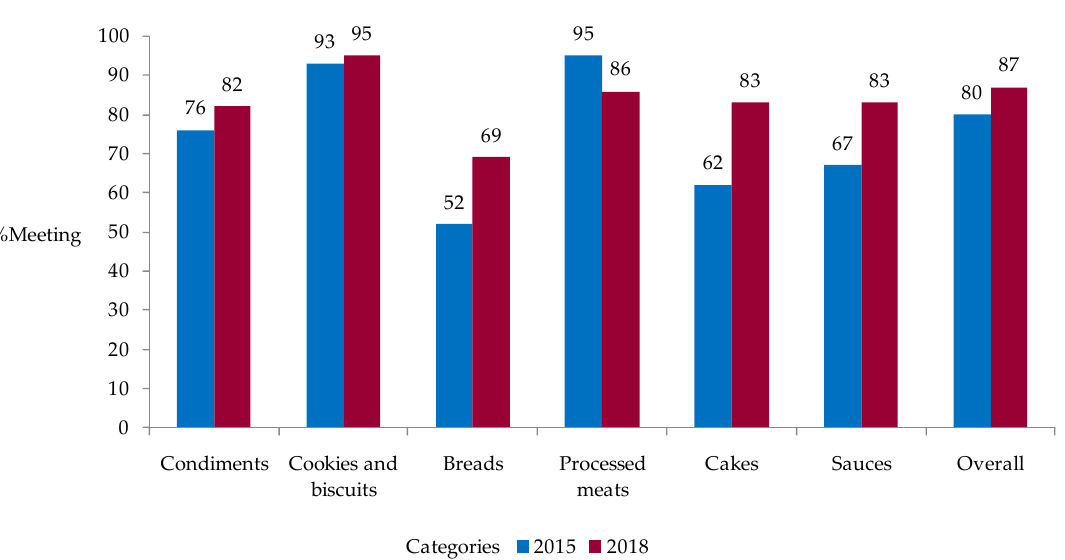
Figure 1. Comparison between years of the compliance with the national target for the sodium reduction in packaged food categories, Costa Rica, 2015–2018.